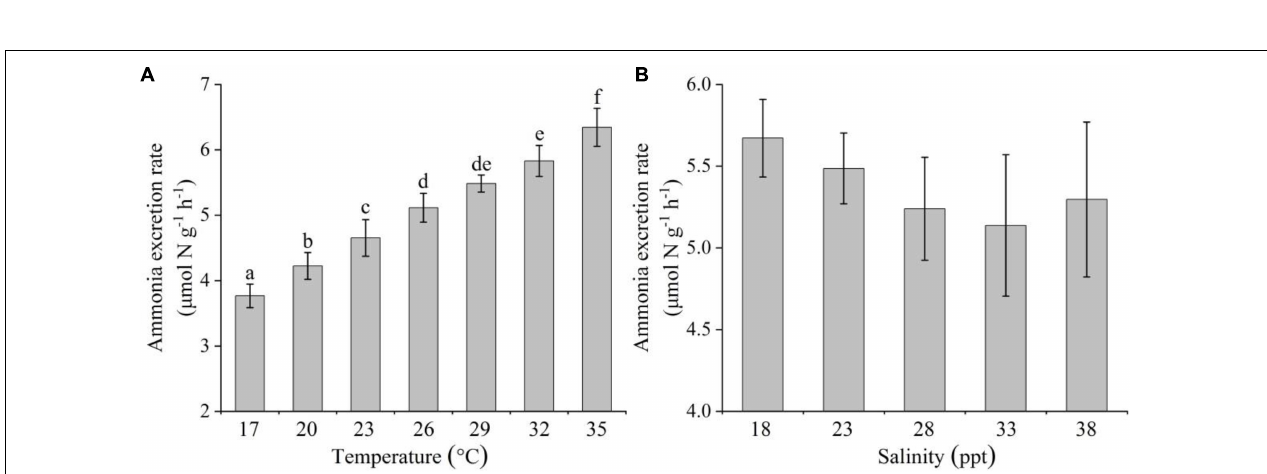
FIGURE 2 | Effects of temperature (A) and salinity (B) on the oxygen consumption rate of Creseis acicula . Bars denote standard deviation. Different superscripts indicate significance ( P < 0.05) among the different temperature and salinity treatments, respectively.